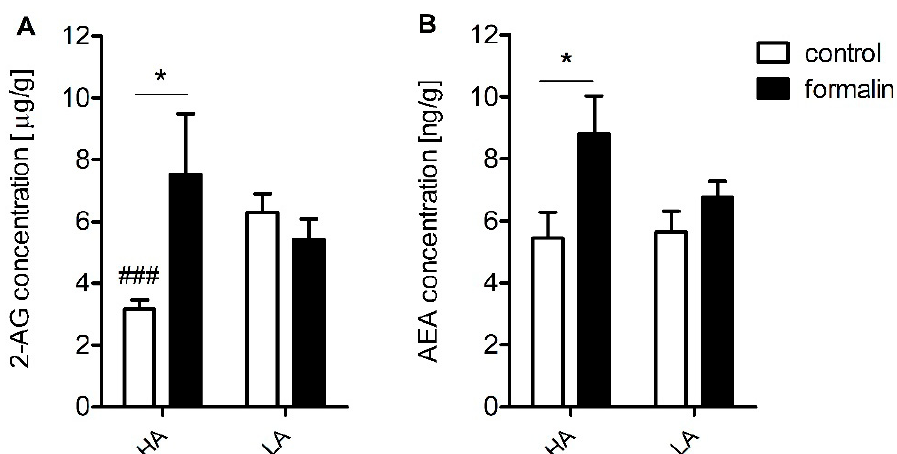
Figure 4. LC-MS/MS analysis of spinal cord 2-arachidonoylglycerol (2-AG) ( A ) and anandamide (AEA) concentration ( B ) in HA and LA mice ( n = 7) injected with either formalin (5% in PBS) or PBS. The effect of formalin injection within each line was analysed with one-way ANOVA followed by Bonferroni’s post-hoc test. Between-line interaction was assessed with two-way ANOVA and Bonferroni’s post-hoc test. Statistical significance was depicted as follows: * p ≤ 0.05 (vs. control within the line); ### p ≤ 0.001 (HA vs.